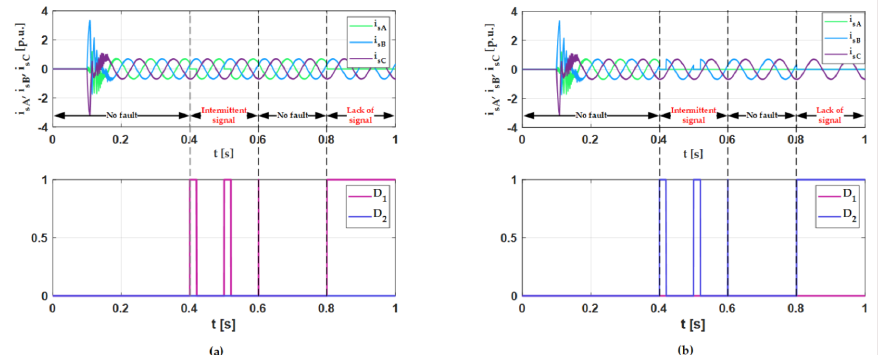
Figure 11. Phase currents under lack of signal and intermittent signal fault in phase A ( a ), B ( b ) and detector responses in scalar control structure for ω ref = 0.6 ω N .